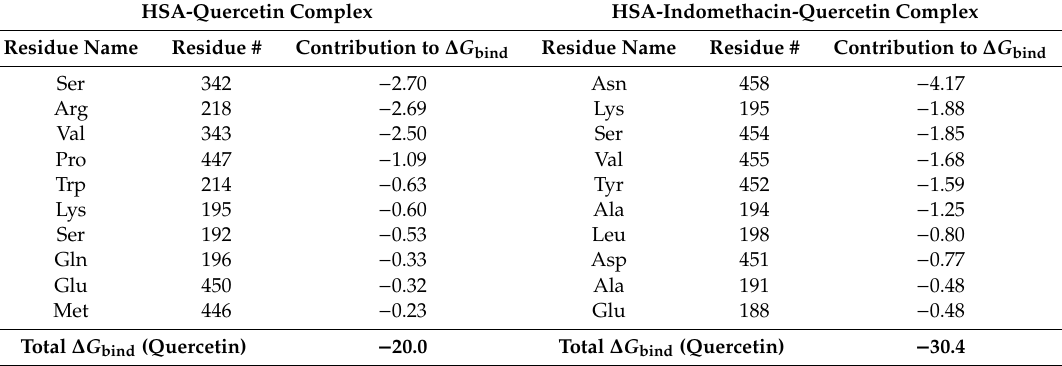
Table 1. Contribution of the top individual residues to the binding of quercetin to HSA in the absence and in the presence of indomethacin obtained with the MM-GBSA approach. All values are in kcal mol –1 (# means